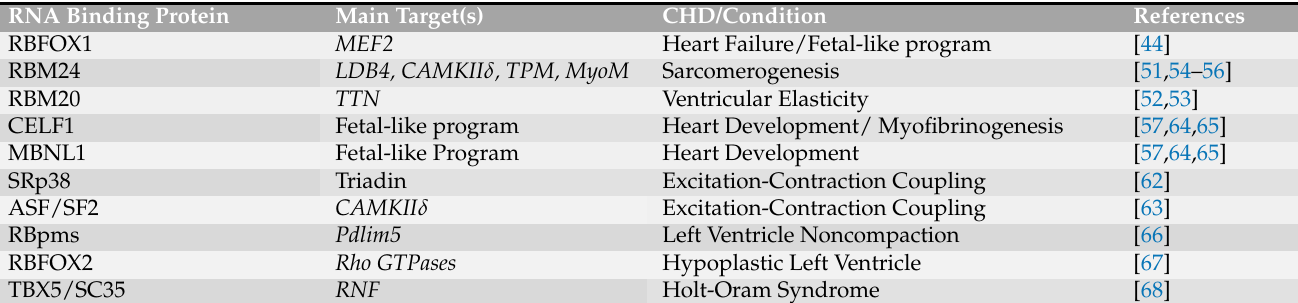
Table 1. RNA binding proteins and their main targets in heart